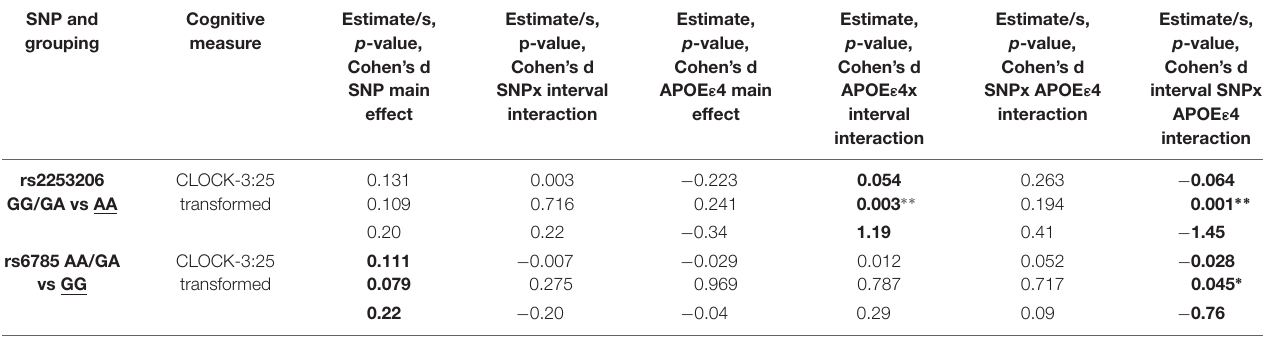
TABLE 2 | Interactions between interval, CREB1 genotypes and APOE ε 4 status significantly influence decline in executive function and semantic memory controlling for baseline age, sex, and education. SNP and